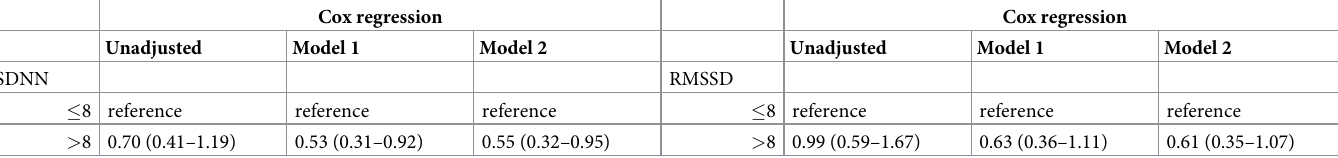
Table 3. Hazard ratio for mortality within three weeks after admission using